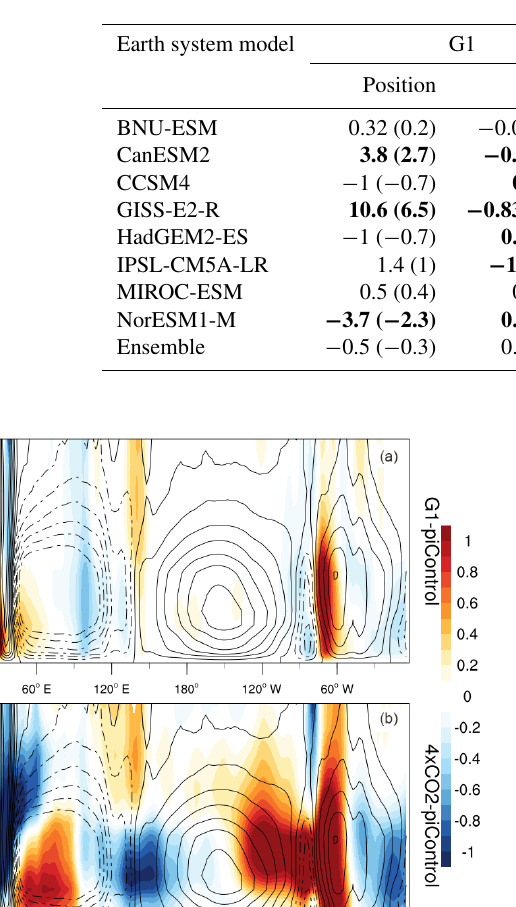
Table 2. The change in Walker circulation position ( ◦ ) and intensity (10 10 kgs − 1 ) in eight models and their ensemble mean. The number in the brackets represents the percentage of change relative to piControl. The negative position (STRF) represents westward movement (weakening) and a positive value represents eastward movement (strengthening). Statistically significant differences at 5% are in shown in bold.